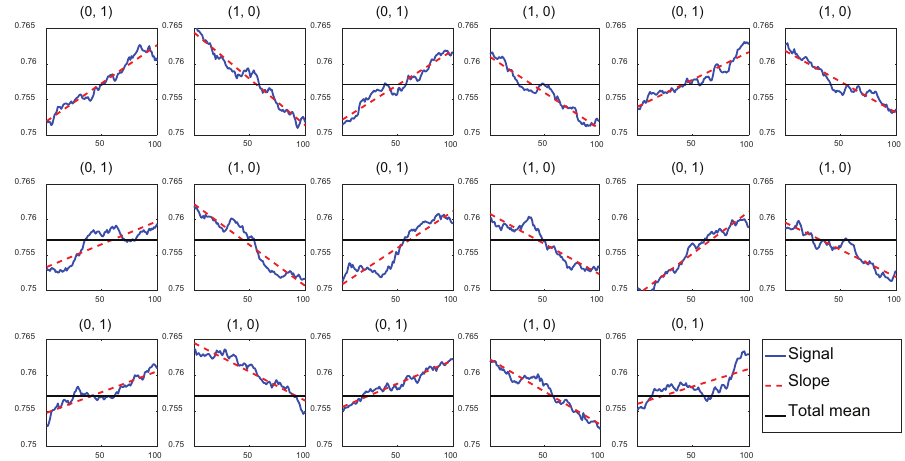
Figure 4. Signal samples after smoothing for different bit pairs and corresponding first-order curve-fitting